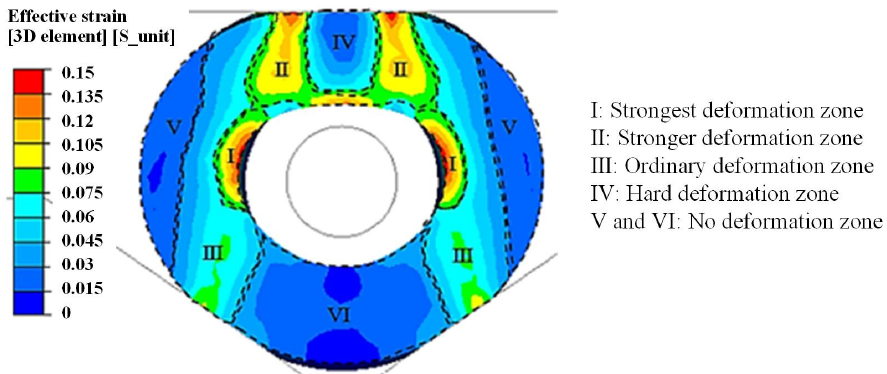
Figure 7. Effective strain distribution of single-step pressing on the cross-section.